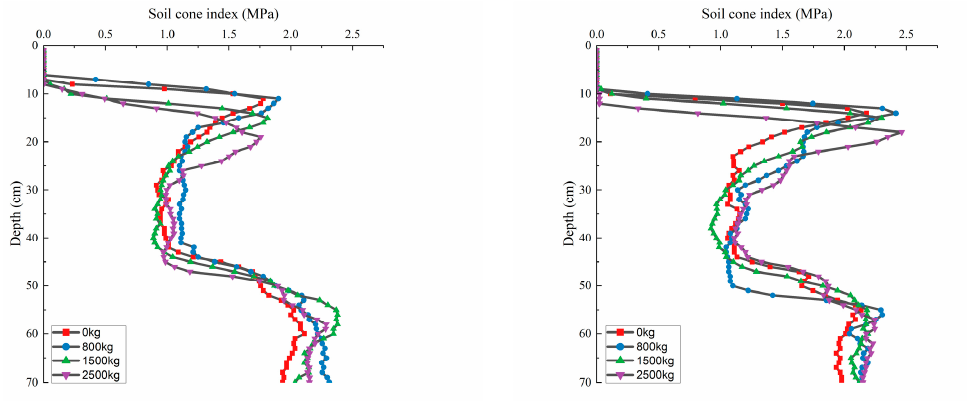
Figure 13. Soil cone index with different numbers of passes in different traction conditions.